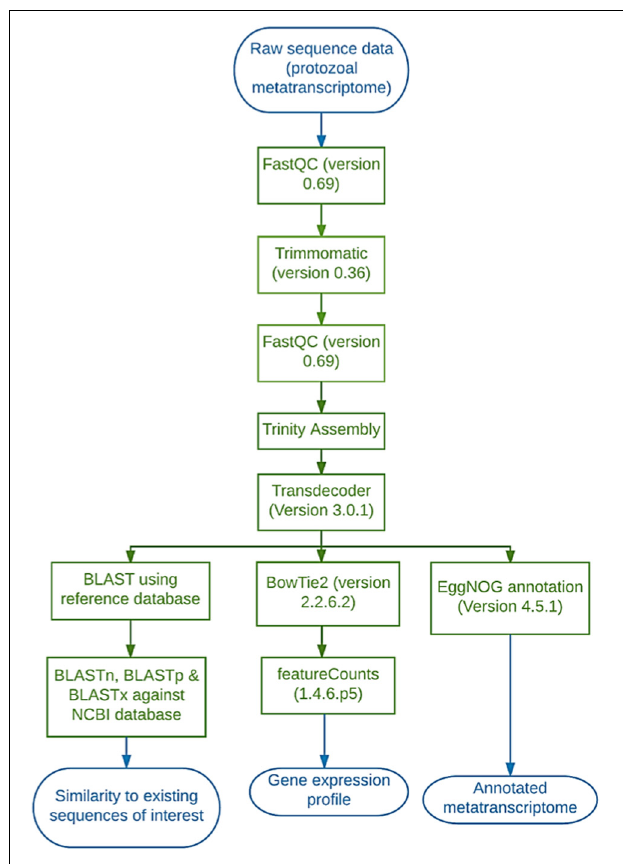
FIGURE 1 | Diagrammatic representation of the workflow employed on the Galaxy platform to analyse the protozoal